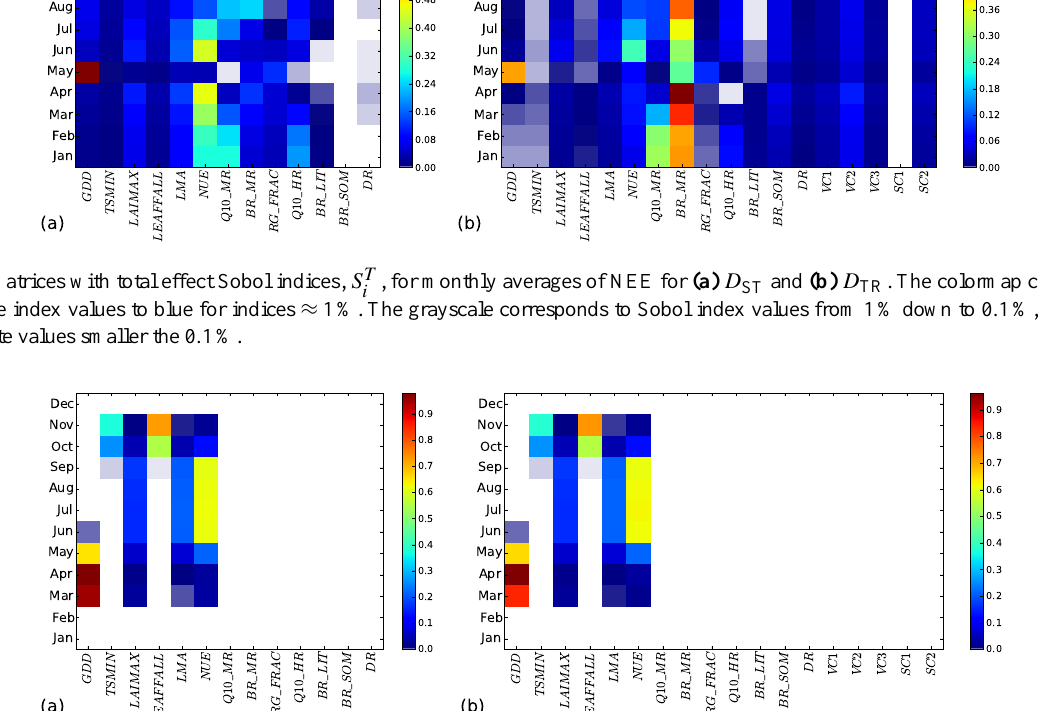
, for monthly averages of GPP for (a) D ST and (b) D TR . The colormap setup is similar i